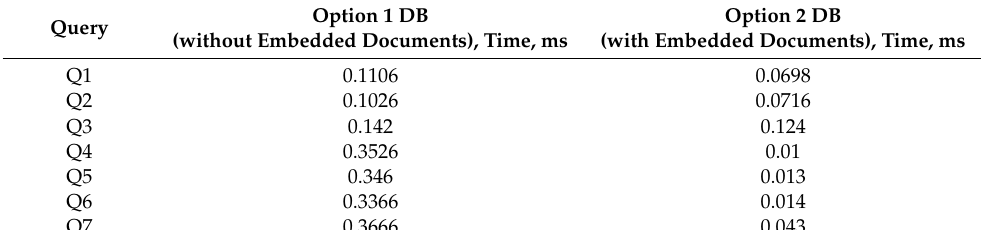
Table 1. The speed of execution of queries to document databases: without embedded documents and with embedded documents.